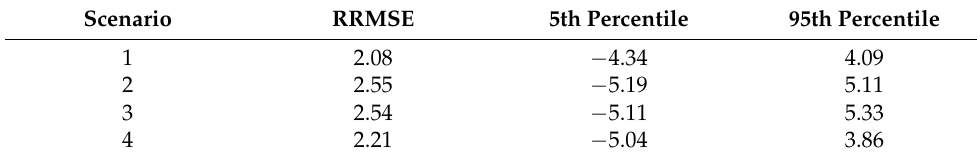
Table 2. Summary of surface velocity prediction errors and prediction ranges